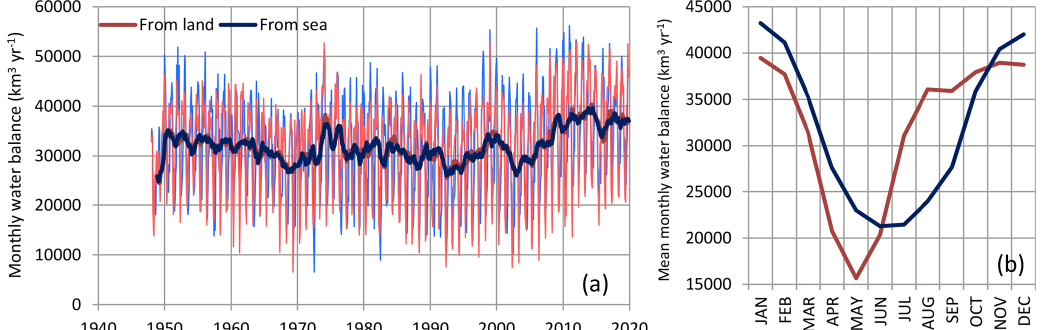
Figure 15. (a) Final global water balance on land and sea from the NCEP–NCAR reanalysis. Thin and thick lines of the same colour represent monthly values (but with rates expressed in km 3 yr − 1 ) and running annual averages (right aligned), respectively. (b) Average seasonal variation of the water balance.